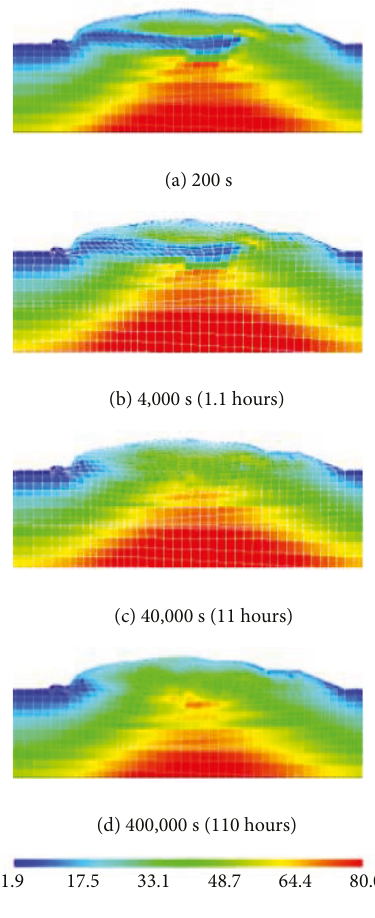
Figure 33: Distribution of mean e ff ective stress during reconsolidation (unit: